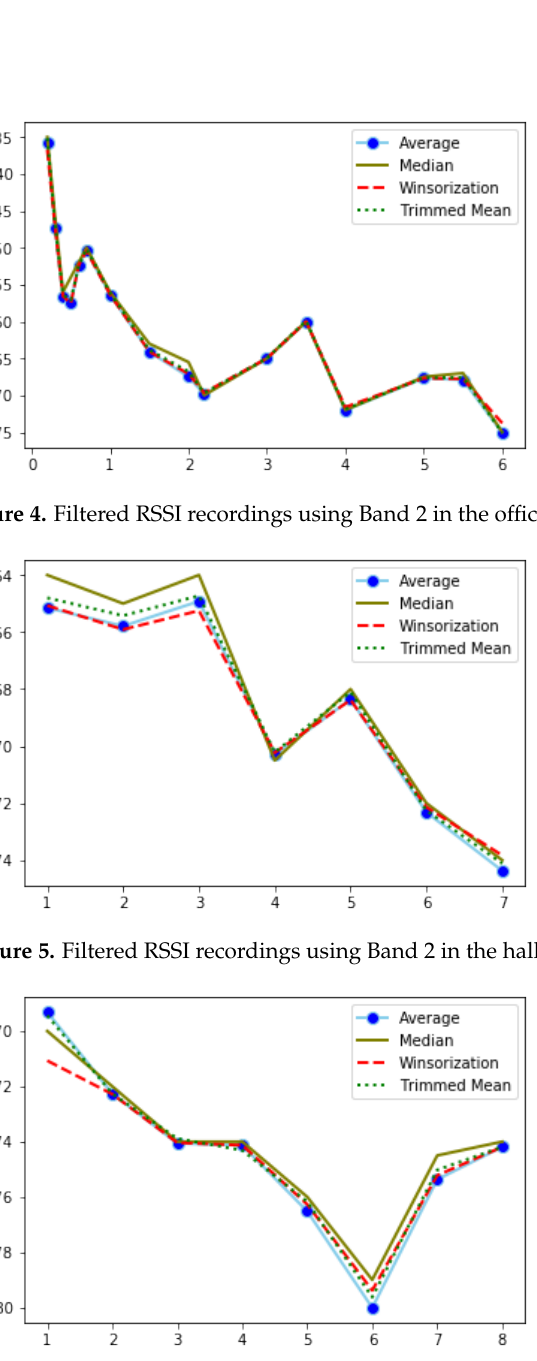
Figure 6. Filtered RSSI recordings using Band 2 in the outdoor